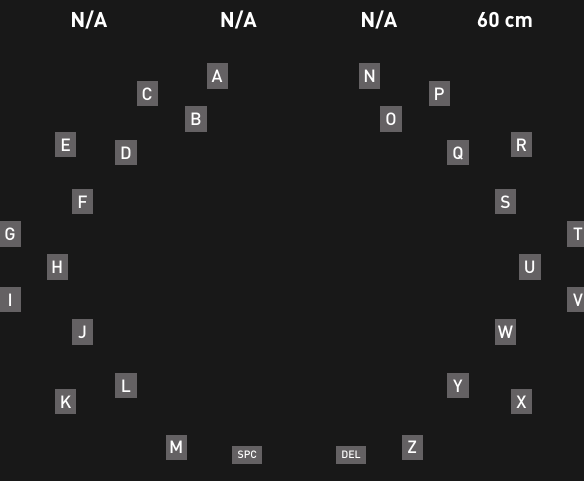
Figure 9. Lateral Single Character Speller, similar to [81]. Figure modified from